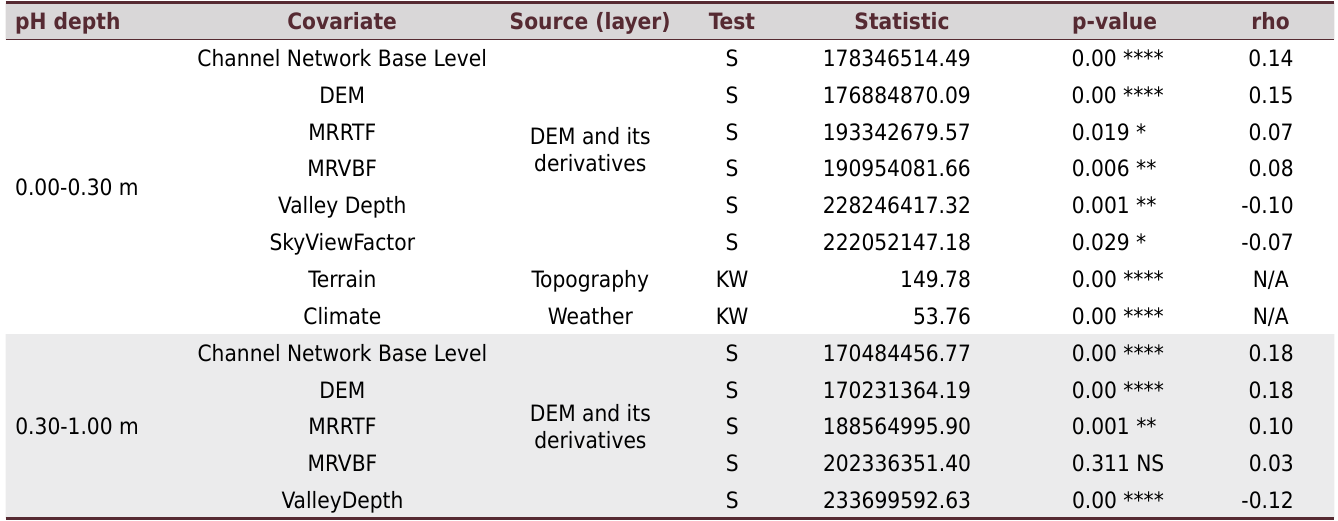
Table 5. Spearman’s (S) rho test to determine the association between pH at two layers and their optimal continuous covariates. Kruskall Wallis (KW) is also provided when comparing the means of pH among groups from optimal categorical variables pH